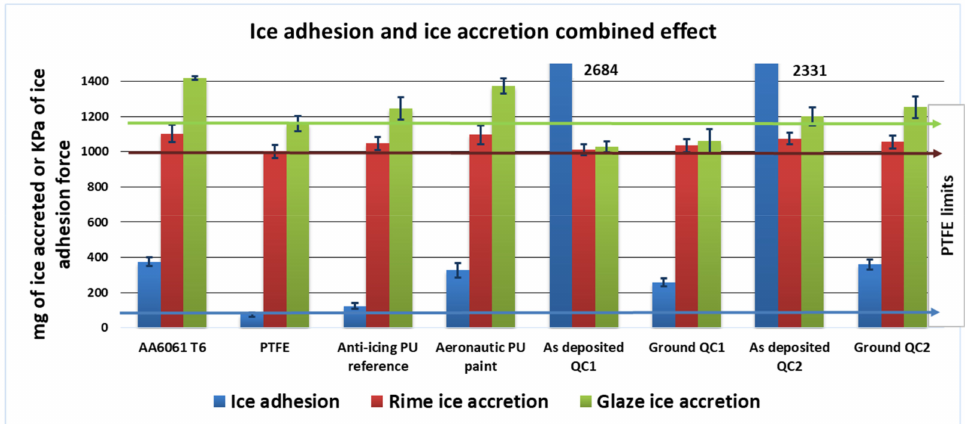
Figure 21. Ice adhesion and ice accretion (Rime and Glaze) results. The horizontal arrows indicate the PTFE values (green for glace ice accretion, red for glaze ice accretion and blue for ice